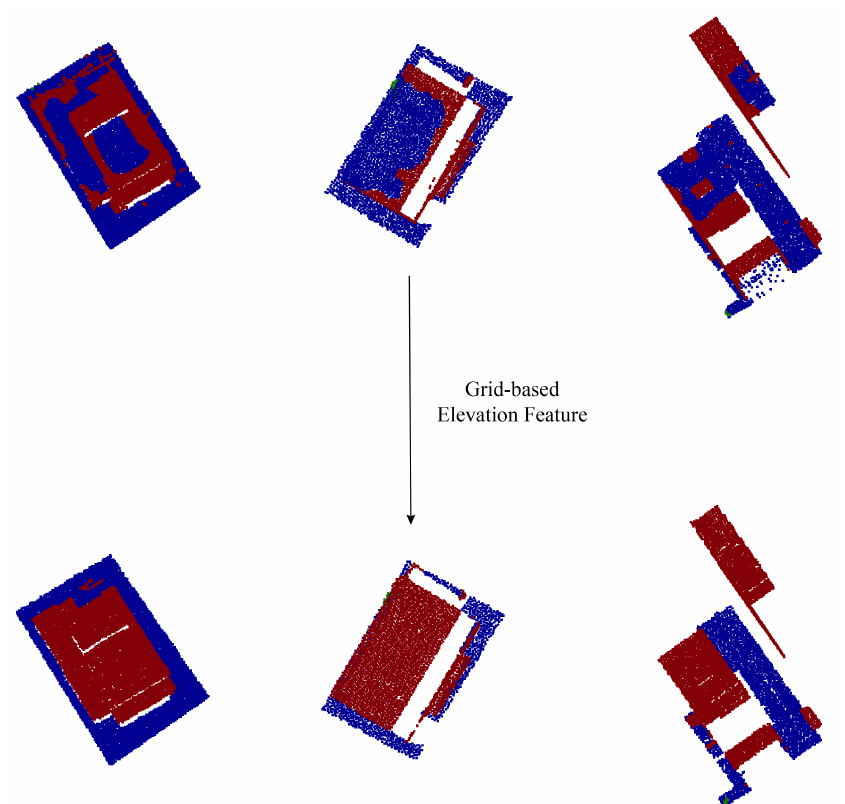
Figure 6. The comparison of the classification accuracy before and after using the grid-based elevation features on the Toronto